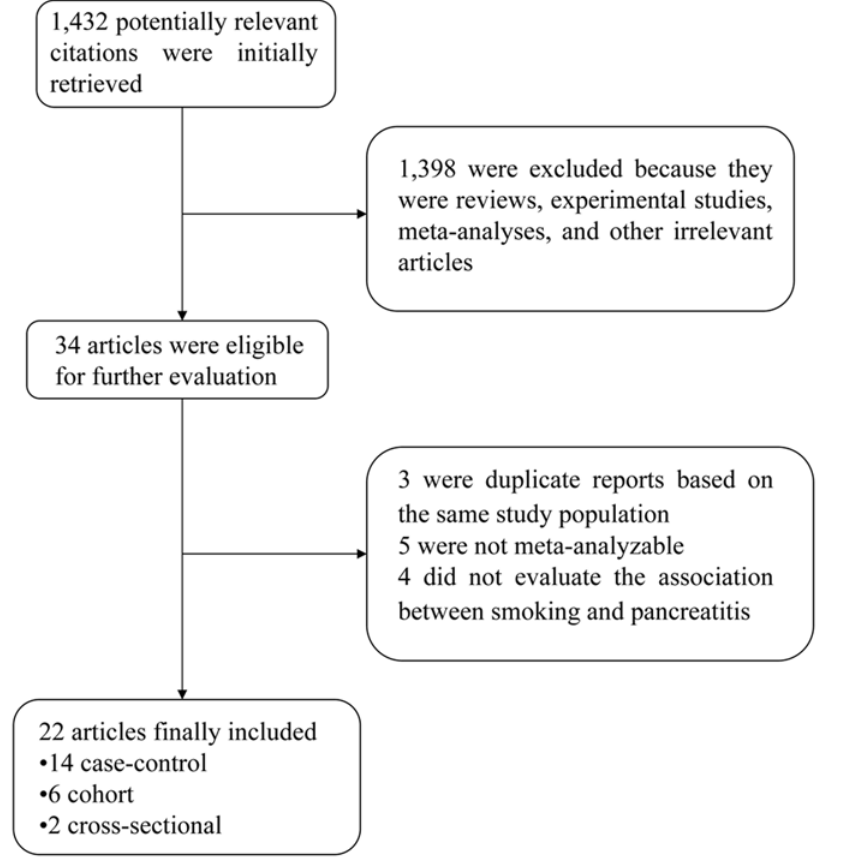
Fig 1. Flow chart of the study